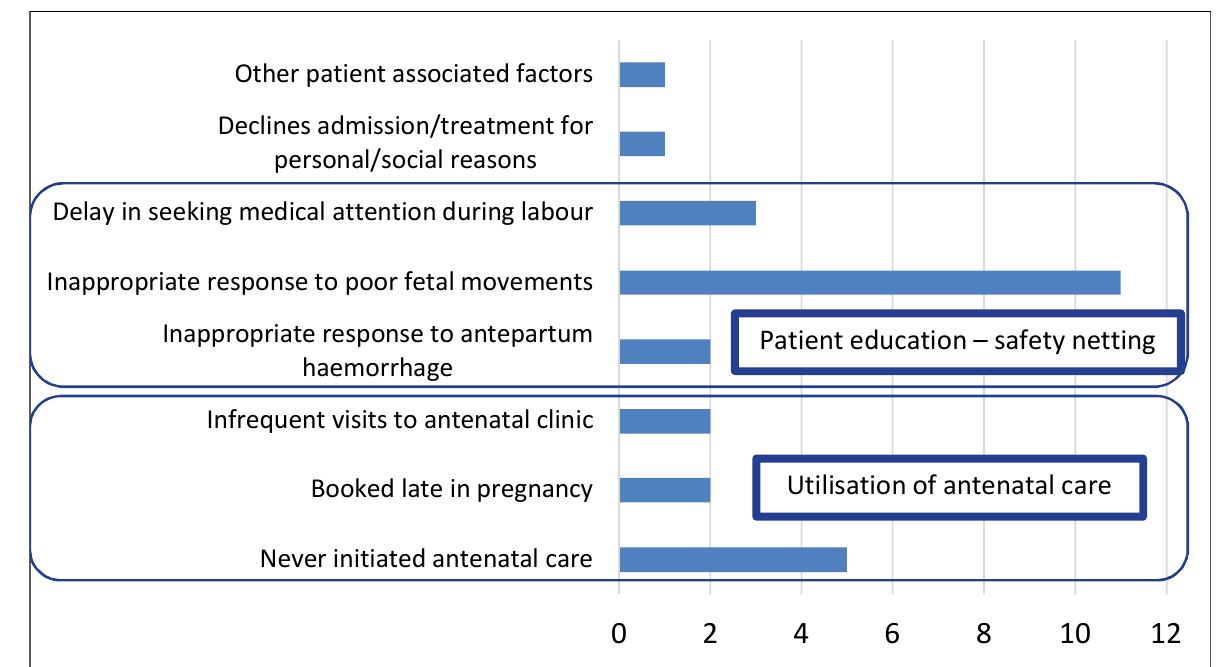
Figure 3: Analysis of the 27 patient-associated modifiable